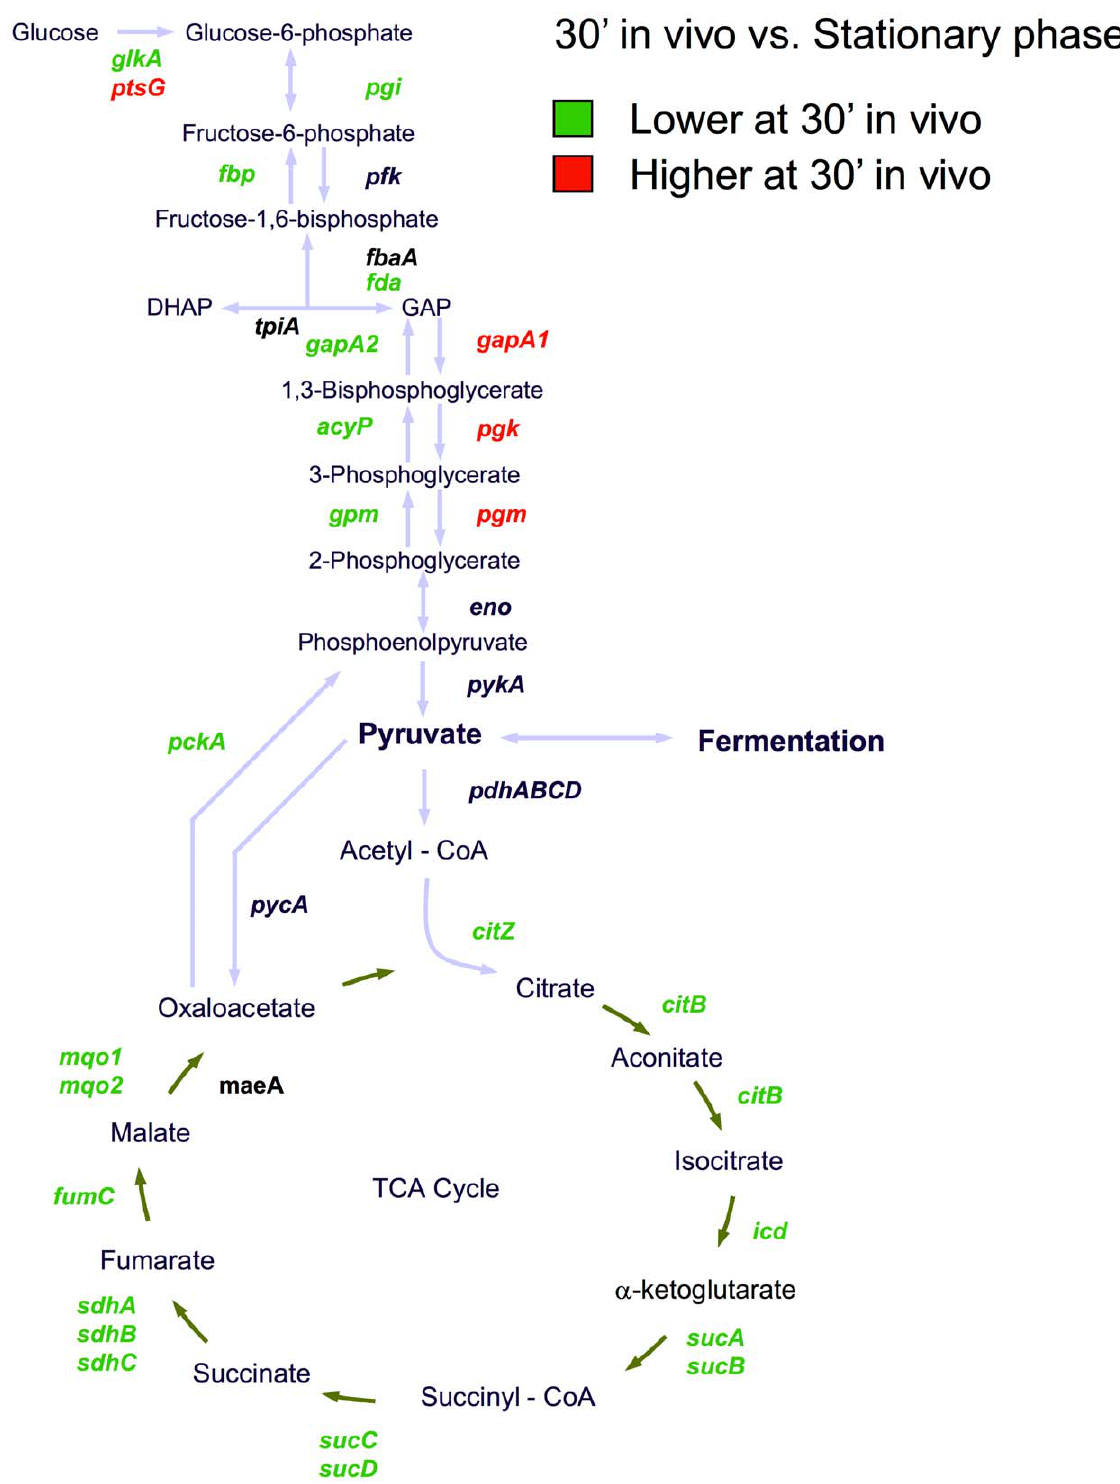
Figure 6. Expression of central metabolic pathways. Genes involved in glycolysis, gluconeogenesis, and the TCA cycle with their respective transcriptional activities are shown. Genes with higher transcription after 30 9 in the mouse airway compared to stationary phase cells are labeled in red, those with lower transcription are labeled green and no change is indicated with black.